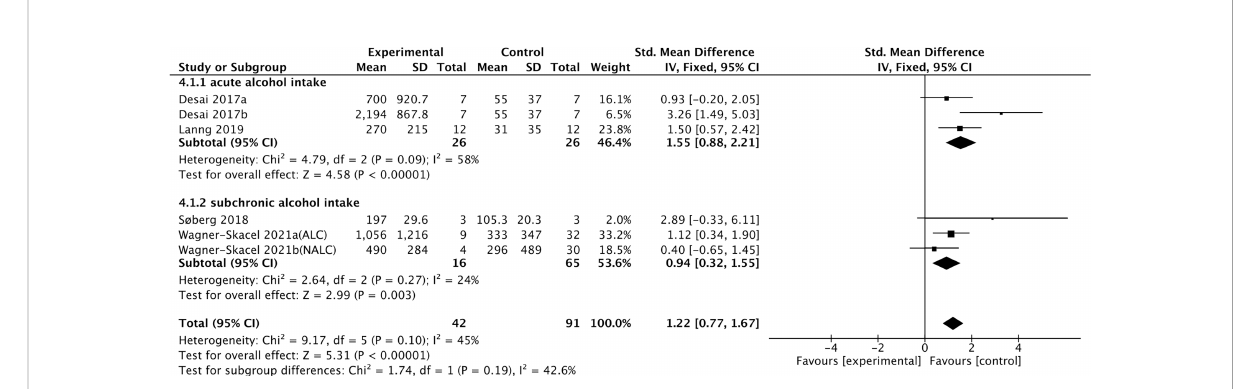
FIGURE 4 Forest plot of cFGF21 concentration in individuals before and after alcohol consumption. Fixed effect models were used as the pooling method. The mean value refers to the mean cFGF21 concentration in each group. cFGF21, circulating fi broblast growth factor